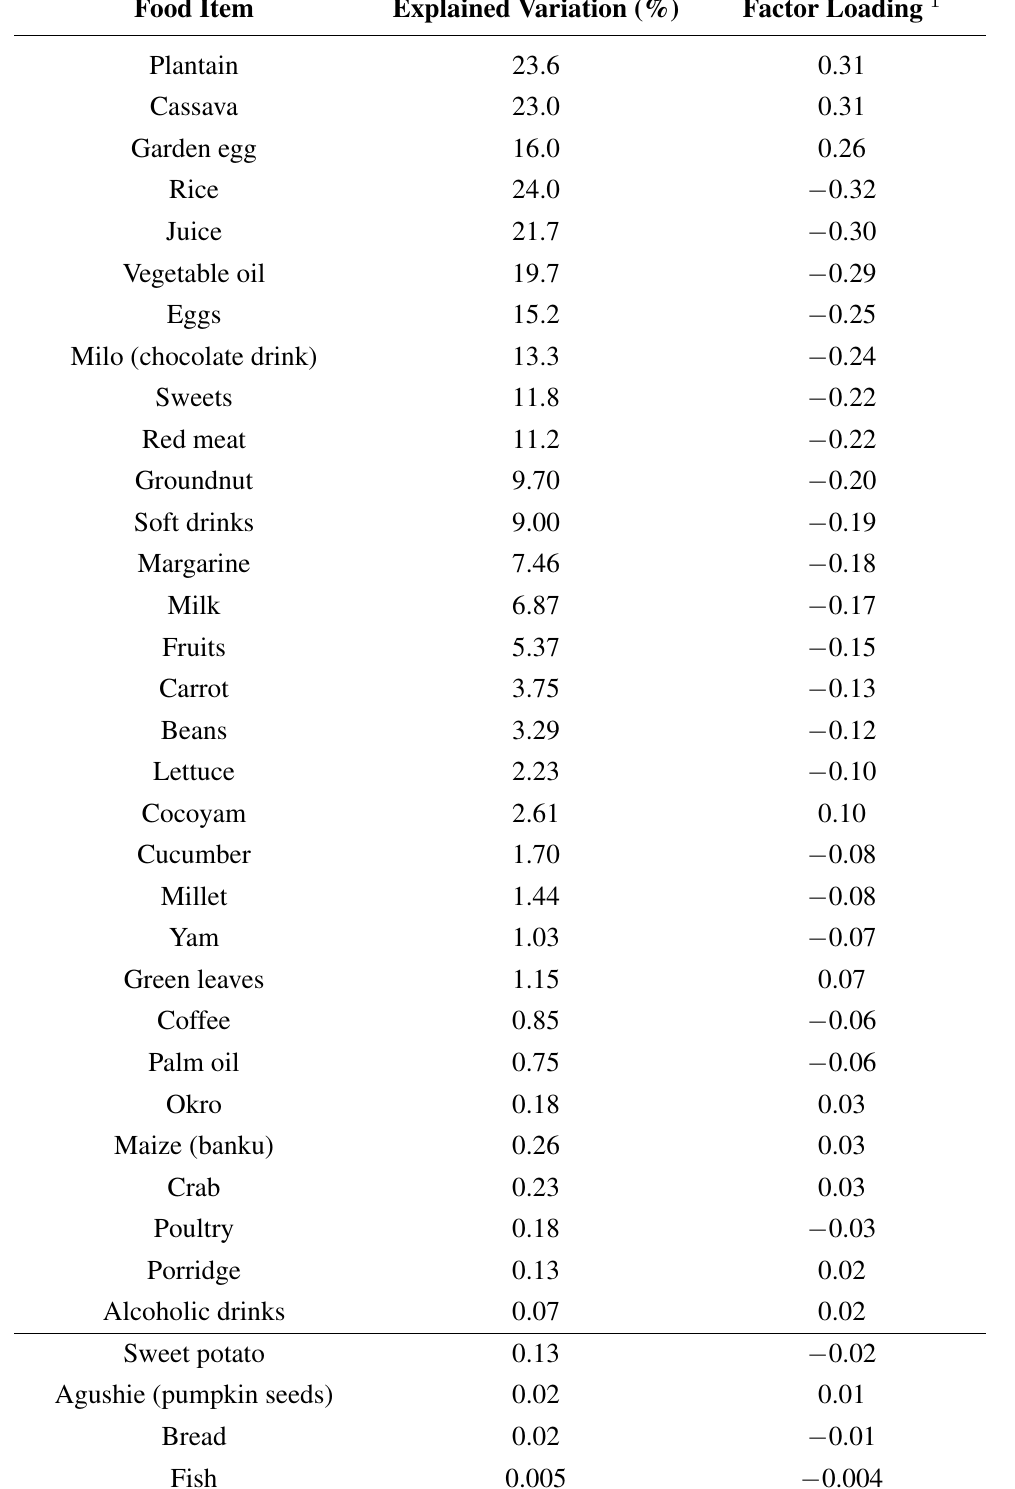
Table 2. Percentage of food variation explained by first dietary pattern score and factor loadings of all 35 food items derived by reduced rank regression in the training set ( n =